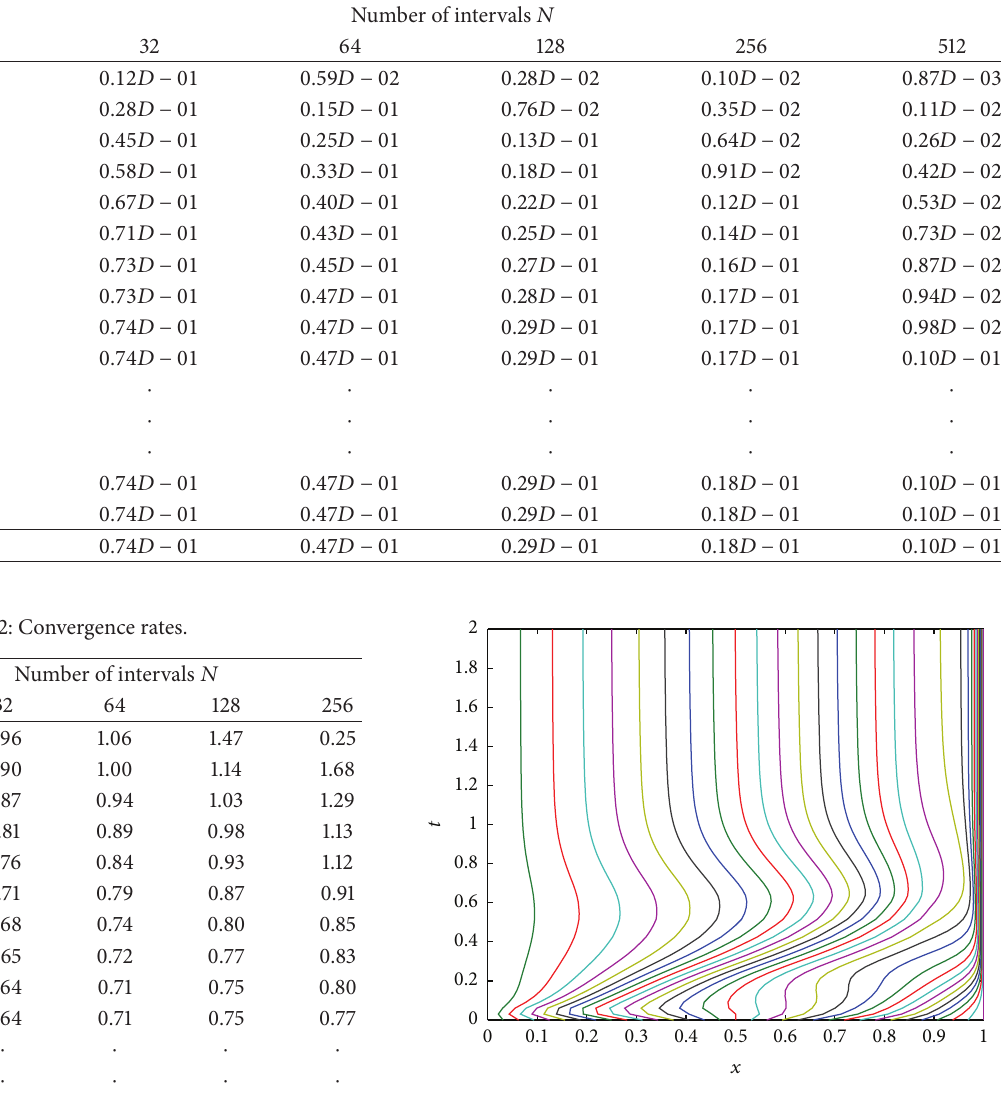
Table 1: Maximum pointwise errors.